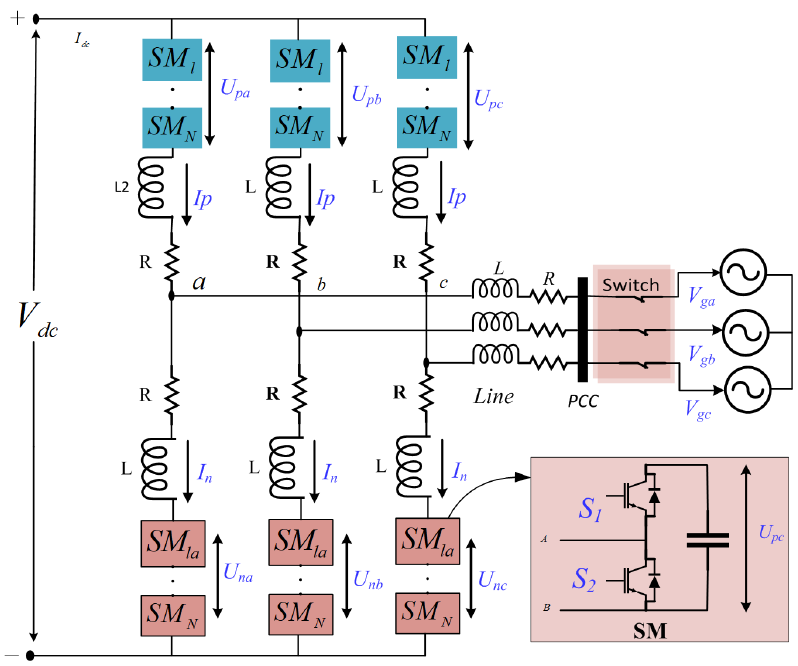
Figure 11. Three-phase Modular Multilevel Converter topology [69]. Table 3. List of some existing worldwide MMC-VSC projects and their basic